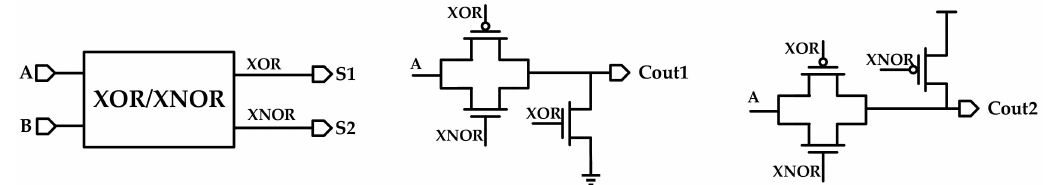
Figure 2. Schematic of the first dual carry adder applied in single-stage CSLA.